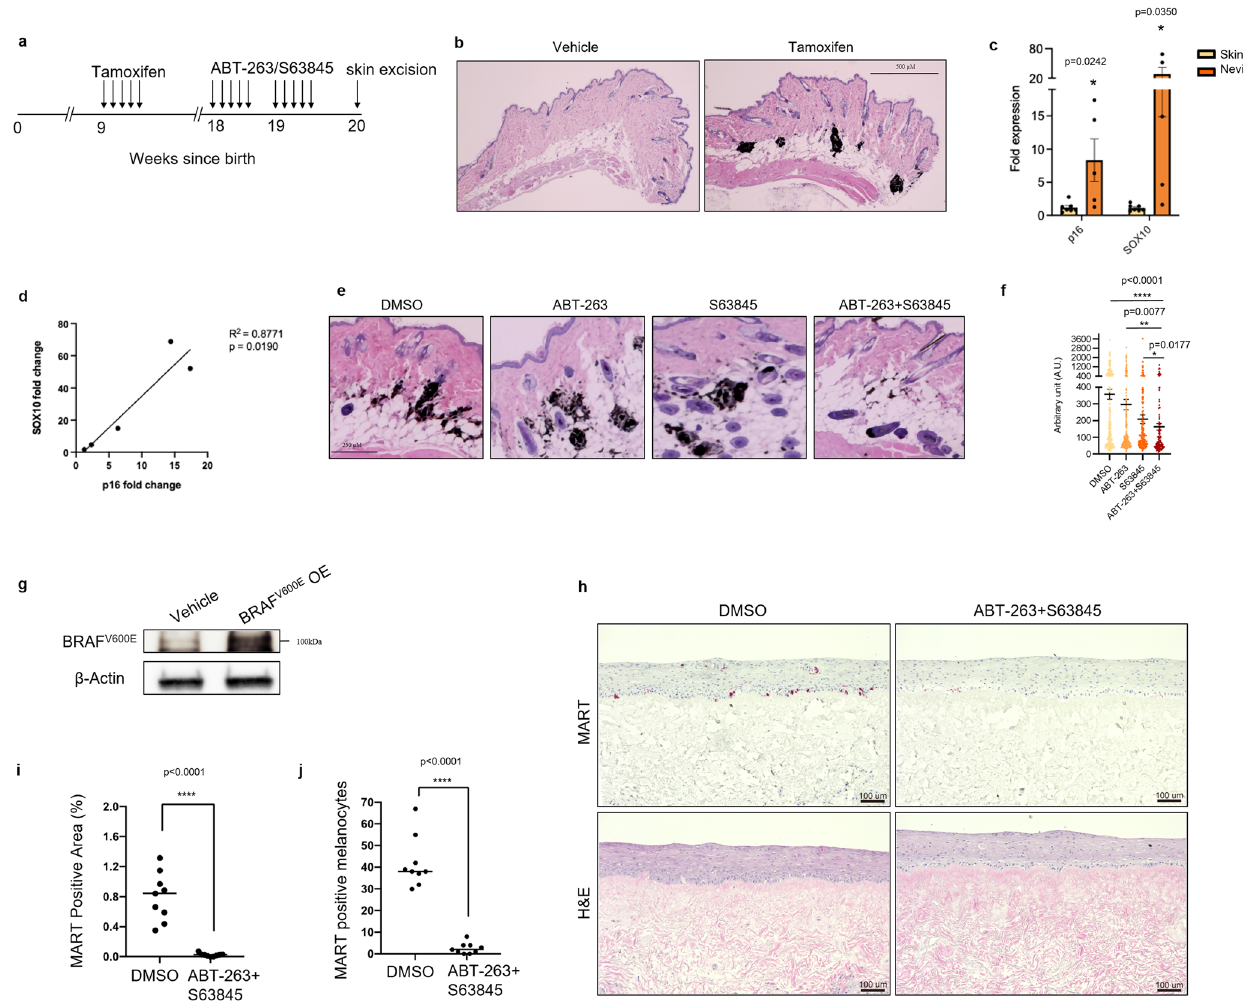
Fig. 4 | ABT-263 and S63845 can induce death in mouse nevi and human skin organoids. a Schematic diagram of in vivo experiments in this study. b H and E section of nevi in tamoxifen-treated mice. Images are representative of N =10 independent sections. Scale bar=500 μ M. c mRNA analysis of p16 and SOX10 expression between skin ( n =7) and nevi ( n =5). Error bars=S.E.M. d Scatter ana- lysis of p16 and SOX10 in nevi. e H and E sections of mouse skin in treated mice. Images are representative of N =10 independent sections. Scale bar=250 μ M. f Nevus density quanti fi cation of DMSO ( n =4), ABT-263 ( n =4), S63845 ( n =3)and ABT-263/S63845 ( n =4) treated mice. g Western blot of BRAF V600E overexpression (OE) in melanocytes used for organotypic cultures as in h – j . The image is